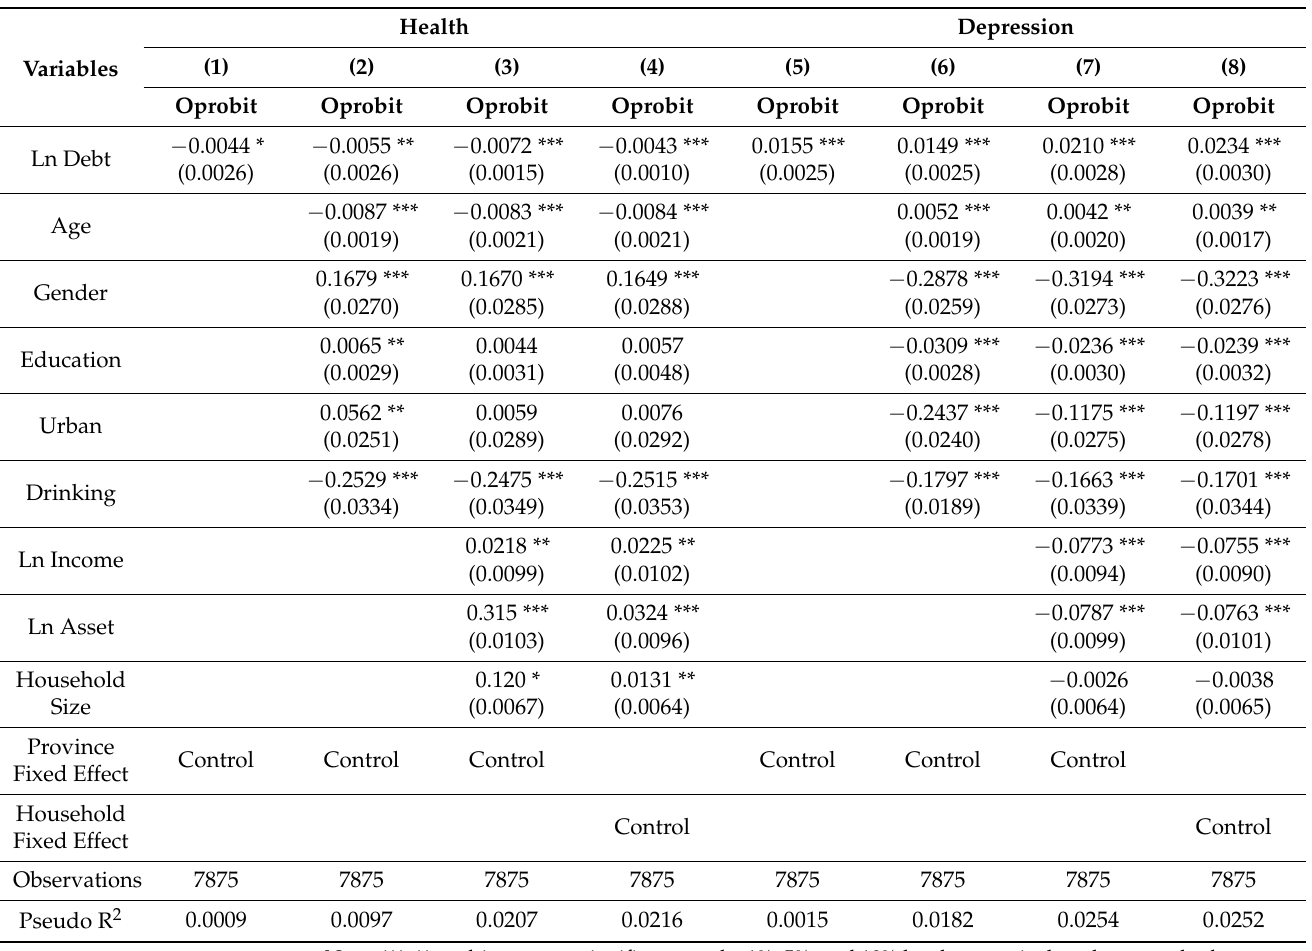
Table 3. Oprobit regression analysis of the impact of household